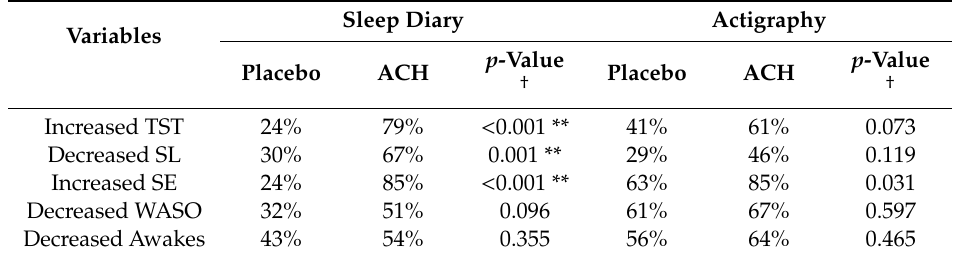
Table4. Ratioofparticipantswithimprovedsleepparametersincontrol(placebo)andtest(ACH)phases. Table 4. Ratio of participants with improved sleep parameters in control (placebo) and test (ACH) phases.